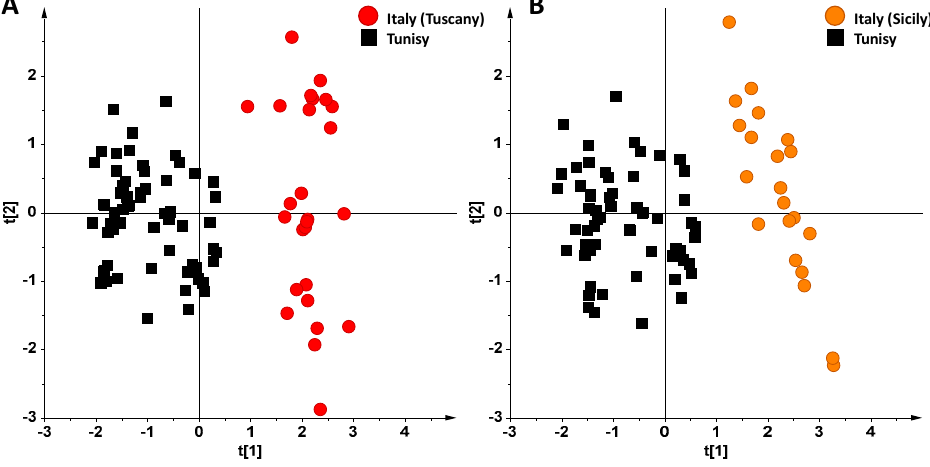
Figure 3. PCA scoreplots for EVOOs from Tuscan ( A ) and Sicilian ( B ) Italian regions vs. Tunisian oils.